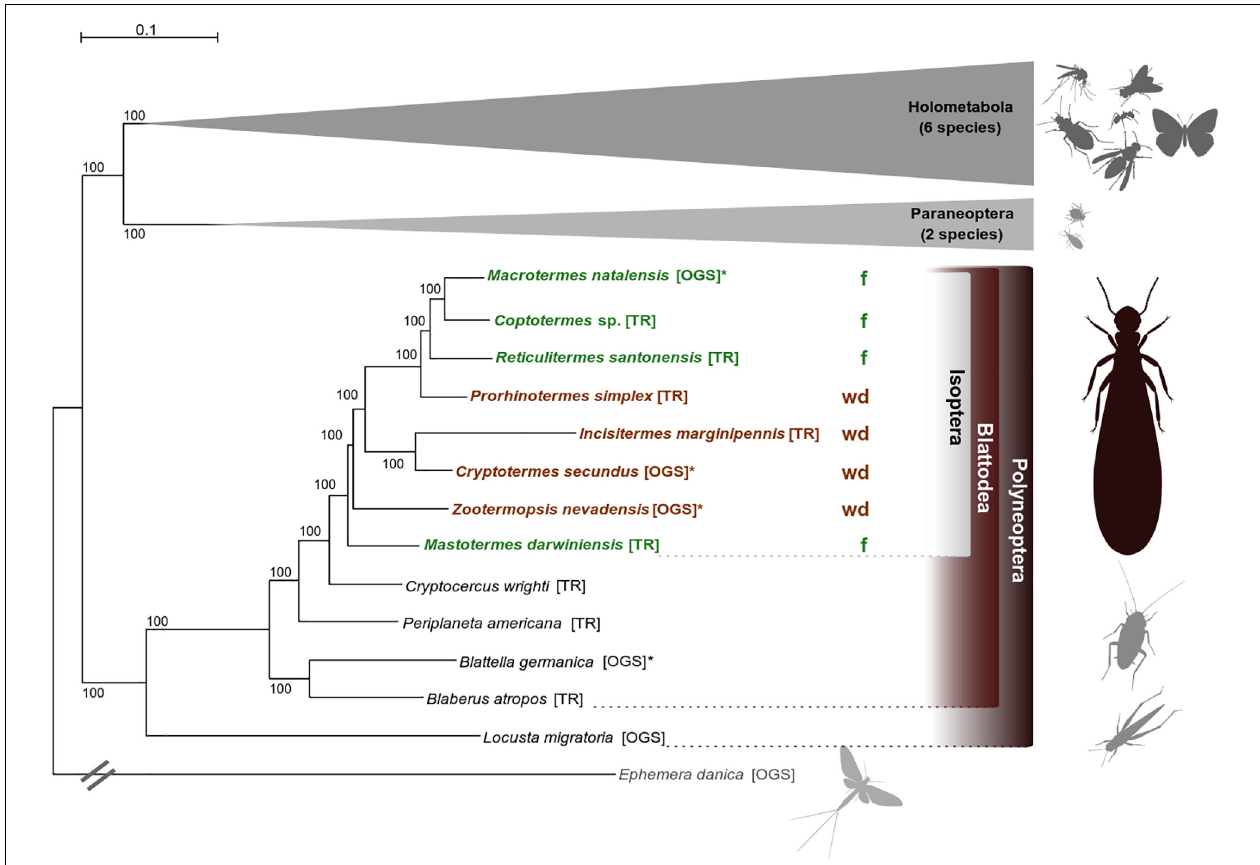
FIGURE 1 | Phylogenetic relationships. Best ML species tree (out of 50 trees) inferred from a super alignment of 1,178 single-copy orthologs (SCOs) with 555,906 amino acid positions (schematized for Holometabola and Paraneoptera, all ML trees had the same topology). Statistical bootstrap support was derived from 200 replicates. The tree was rooted with the mayfly Ephemera danica (the full tree is provided with the Supplementary Files on DRYAD). Color code: brown indicates wood-dwelling species (wd), green indicates foraging species (f). TR, derived from transcriptome assemblies (Misof et al., 2014; Evangelista et al., 2019); OGS, derived from official gene sets ( Supplementary Table S1 ). The symbol “ ∗ ” indicates reference species whose OGS was used to create the ortholog set. Pictograms were kindly provided by H. Pohl, Jena.